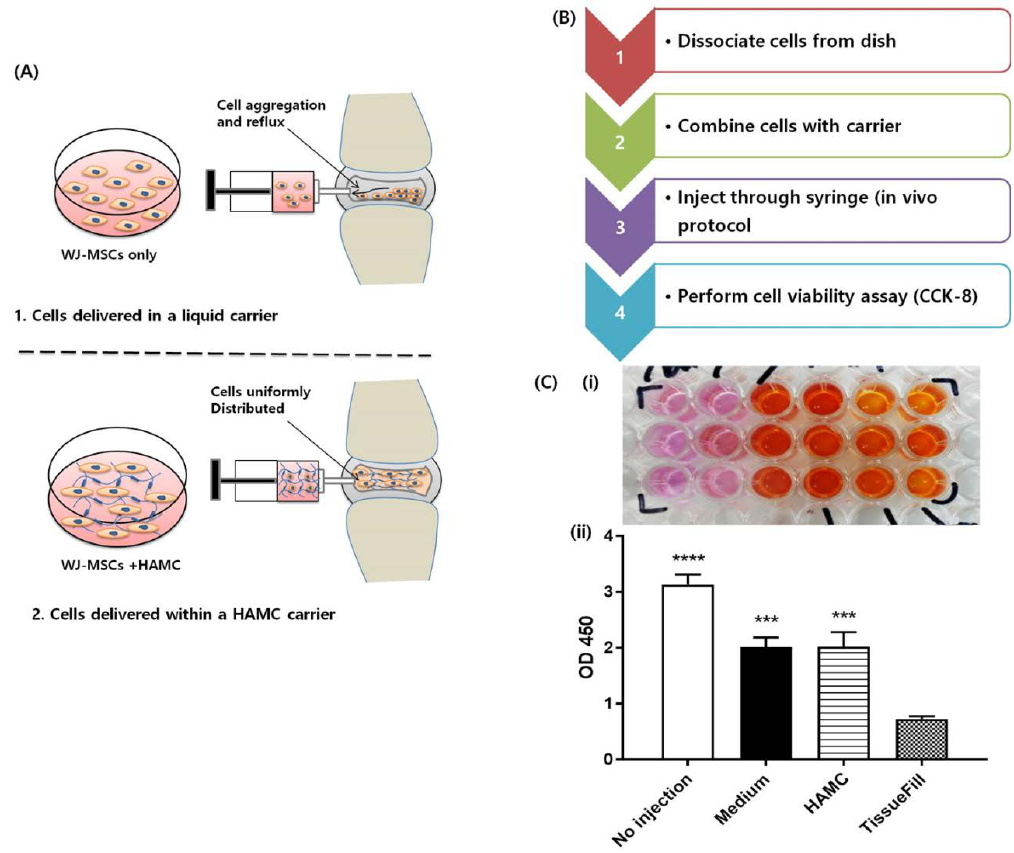
Figure 2. Encapsulation in HAMC maintains post-injection viability compared to TissueFill. WJ-MSCs were encapsulated in different vehicles and injected through a fine-gauge needle to assess post-injection viability. ( A ) Schematic illustrating the comparison of WJ-MSC stability and viability between HAMC-encapsulated, and non-encapsulated WJ-MSCs post-injection. ( B ) Stepwise post-injection procedure. ( C ) (i) Representative CCK-8 assay, (ii) quantitative result after CCK-8 assay, compareing the cell viability of WJ-MSCs in medium alone, TissueFill or HAMC. Cells injected in medium or HAMC retained significantly higher viability compared to TissueFill. Mean + SD, n = 3